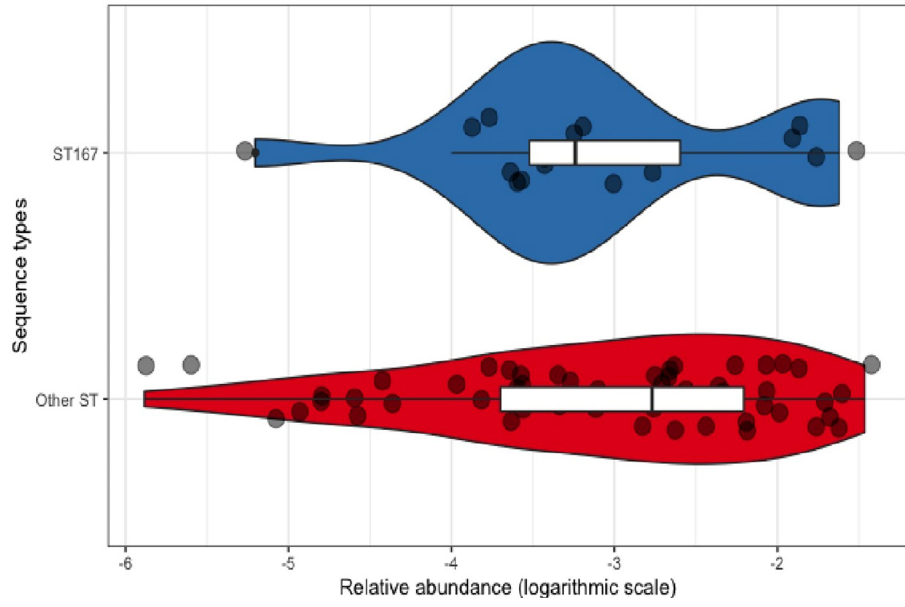
Fig 13. CRE relative abundance of E . coli ST167 versus other ST of E . coli